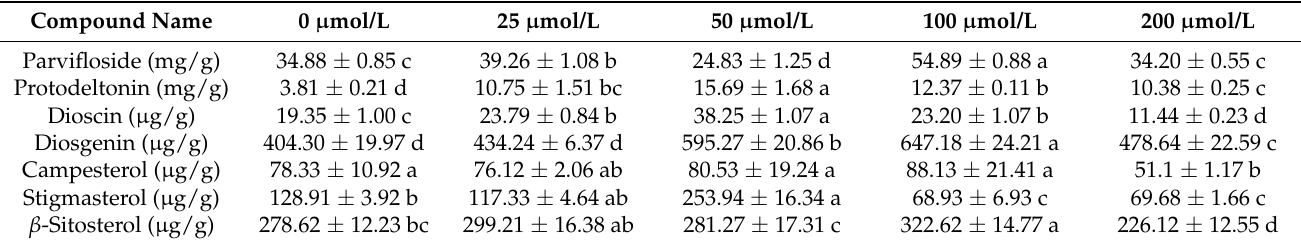
Table 3. Effects of jasmonic acid on steroidal saponin biosynthesis in D. zingiberensis .